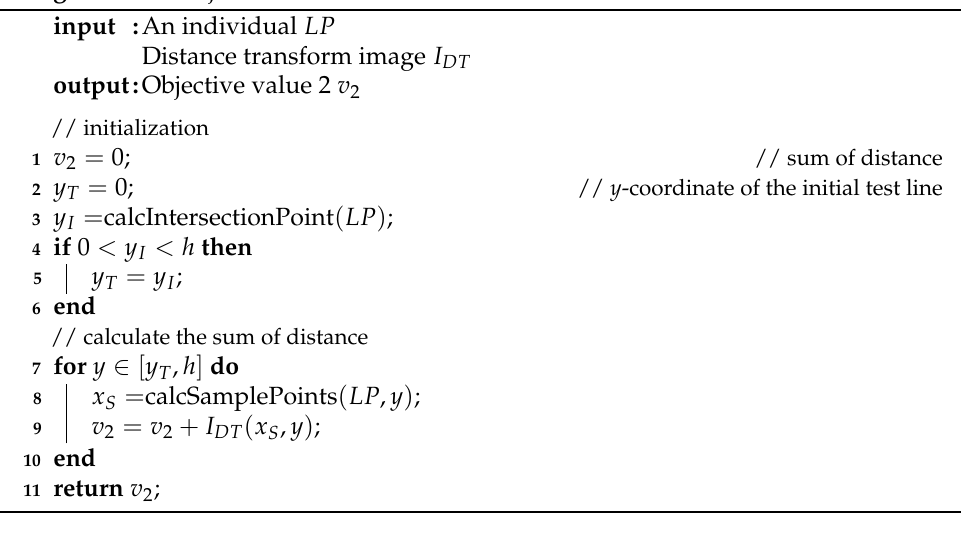
Algorithm 2: Objective Function 2